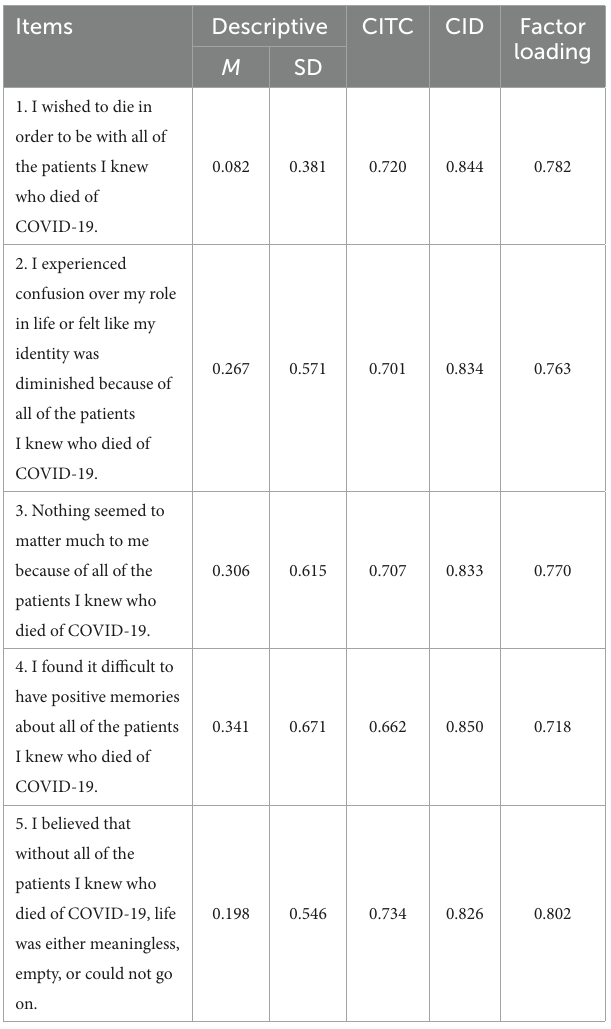
TABLE 2 Item properties of the PGS for healthcare workers.